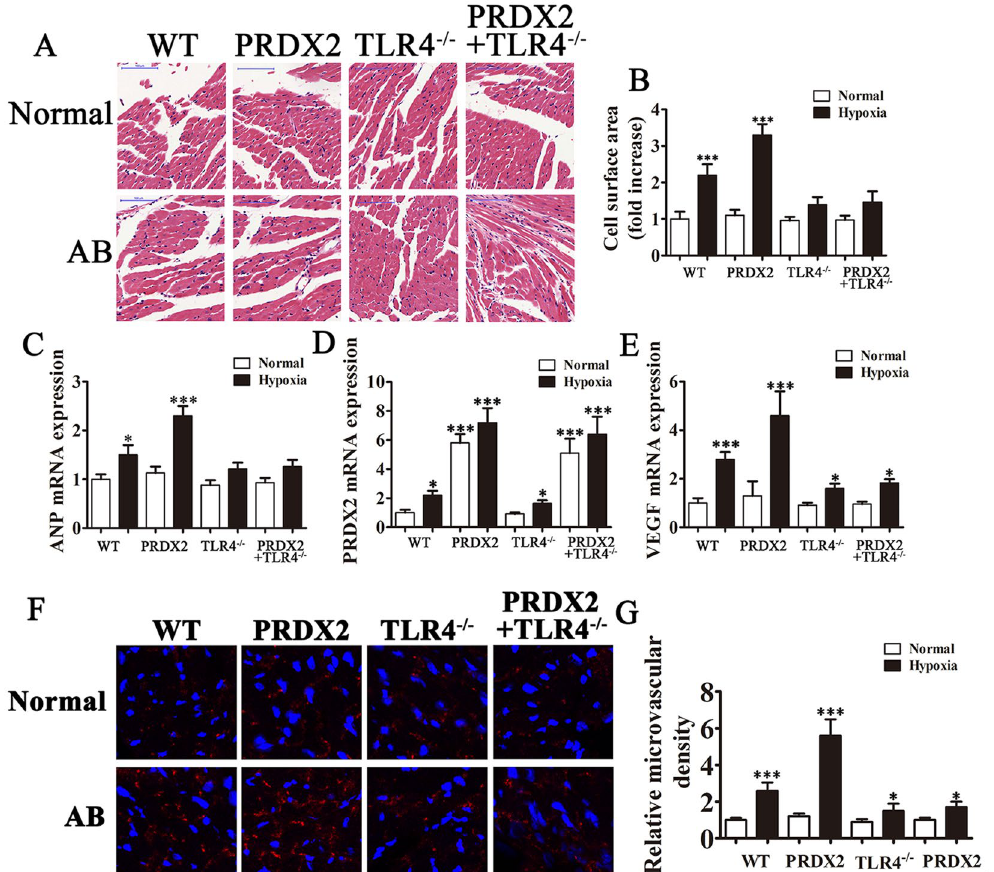
Figure 6. The overexpression of PRDX2 promote angiogenesis and myocardial hypertrophy. After 2 weeks of coronary artery ligation, serum from mice was harvested for RT-PCR analysis and myocardial tissue were harvested 4 weeks after artery ligation for immunohistochemical analysis. ( A ) Effects of PRDX2 on cell surface area of cardiomyocytes. ( B ) Cell surface area was calculated by measuring 10 random cardiomyocytes. ( C – E ) RT-PCR for ANP ( C ), PRDX2 ( D ) and VEGF ( E ) expression. The data are presented as means ± SD from three separate experiments from five to six mice in each group. * p < 0.05, *** p < 0.001 vs normal WT group. ( F ) The formation of microvascular cells in infarction region were stained with CD31. AB, aortic banding. The data are presented as means ± SD from 10 fields in each group. * p < 0.05, *** p < 0.001 vs normal WT